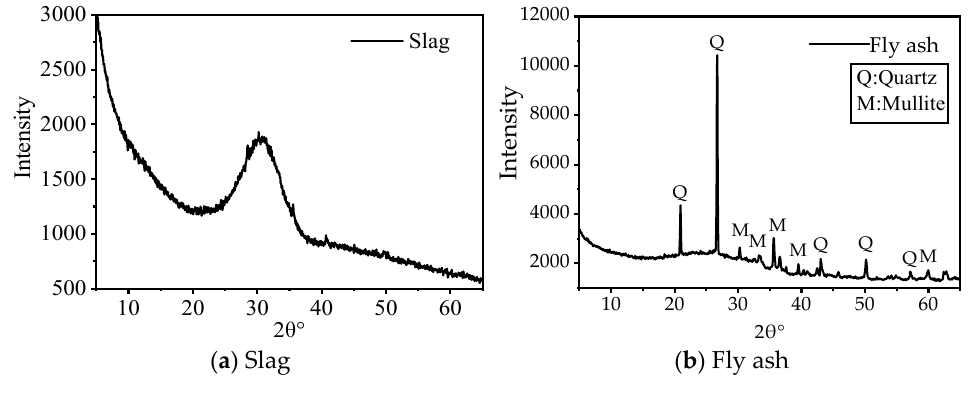
Figure 4. XRD of slag and fly ash. ( a ) Slag; ( b ) Fly ash.